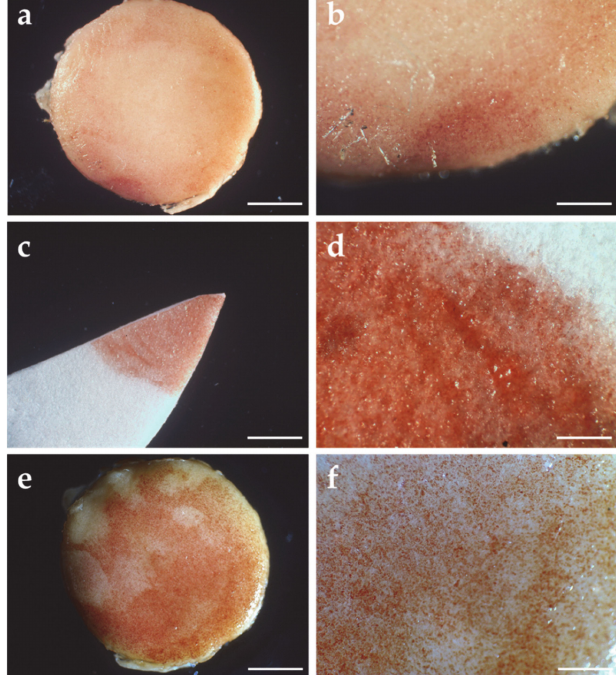
Figure 1. Neutral red assay show red-stained viable cells imaged via stereomicroscopy on human mesenchymal stromal cell (hMSC) / *PCL constructs: ( a , b ) di ff erentiated in static conditions; ( c , d ) di ff erentiated in dynamic conditions; and, ( e , f ) undi ff erentiated in static conditions. ( a , c , e ) Scale bar = 2 mm; ( b , d , f ) scale bar = 600 µ